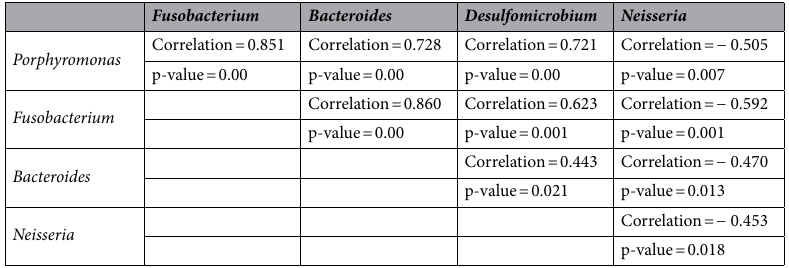
Table 3. Correlation between relative abanudances of Porphyromonas , Fusobacterium , Bacteroides , Desulfomicrobium , and Neisseria in 27 oral macropod samples. Pearson correlation coefficient and its p-value are